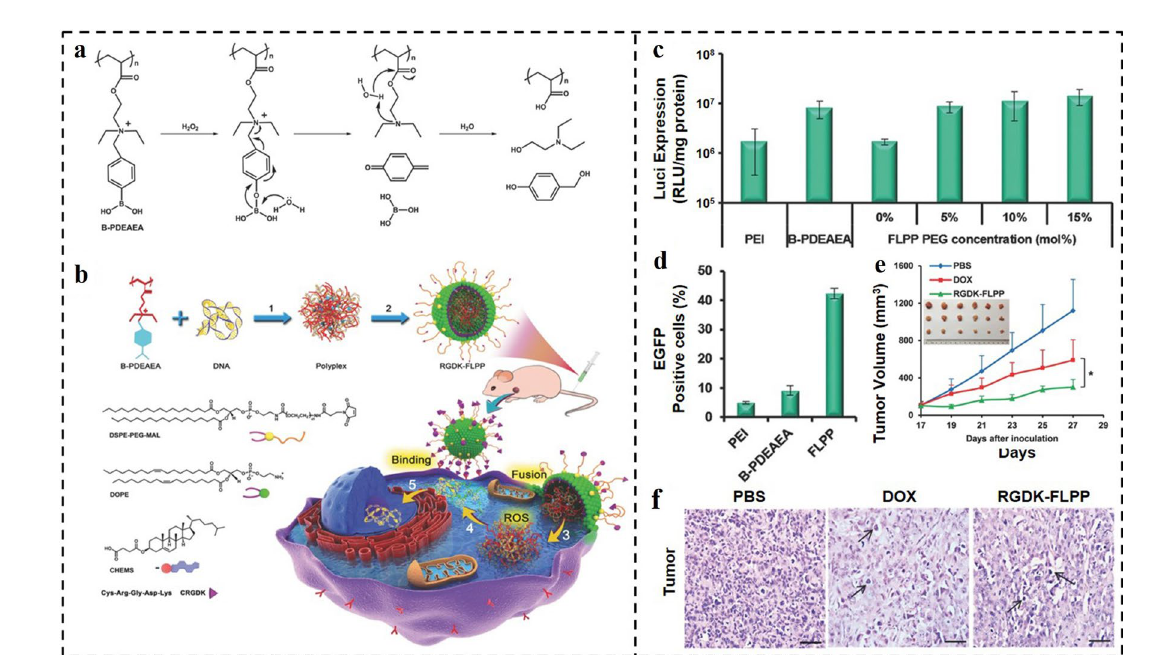
Fig. 9 a , b Schematic representation of ROS-responsive charge-reversal polymer and its CRGDK-receptor targeted fusogenic lipopolyplex (RGDK-FLPPs) for systemic gene delivery. c Luciferase gene transfection efficiency of polyplexes in A549 cells after 48 h. d Enhanced green fluorescent protein (EGFP) gene transfection efficiency in A549 cells of FLPPs in terms of GFP-positive cell percentage measured by flow cytometry. e Antitumor activity of the TRAIL plasmid-loaded RGDK-FLPPs. f Representative histological features of tumors [165]. Copyright 2015, WILEY–VCH